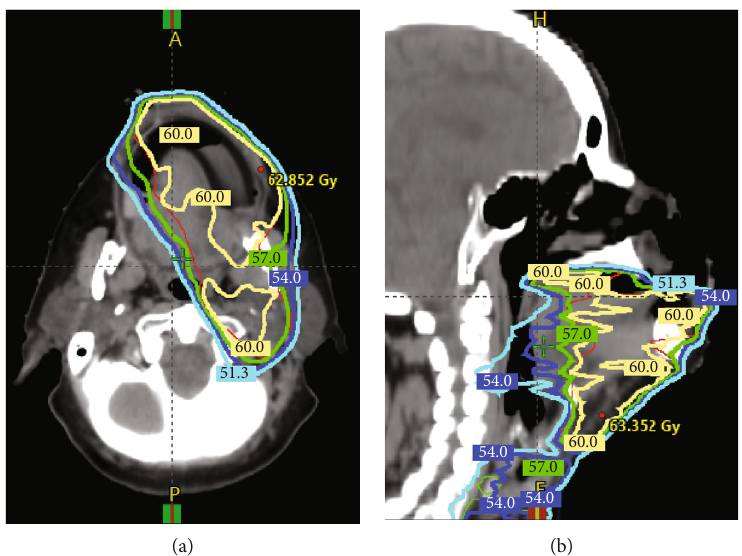
Figure 1: (a, b) Dose lines of radiotherapy treatment showing irradiated regions of the oral cavity.